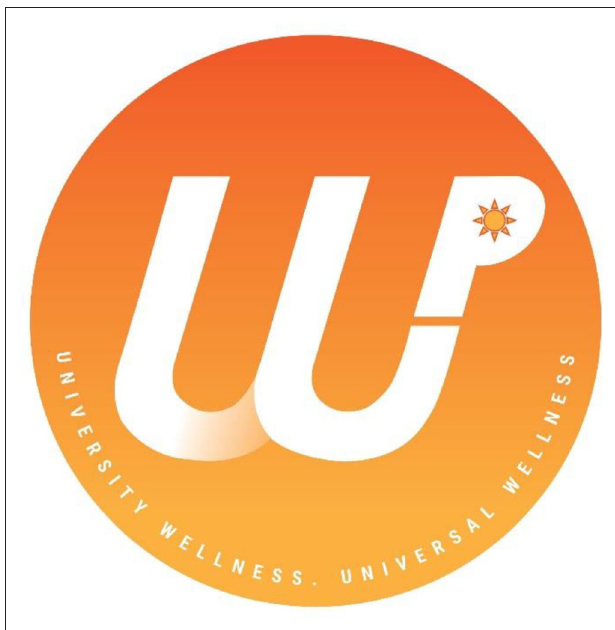
FIGURE 5 | UWP logo. MPH students designed the logo and learnt the importance of branding during the “social and behavior change, effective communication in healthcare”.